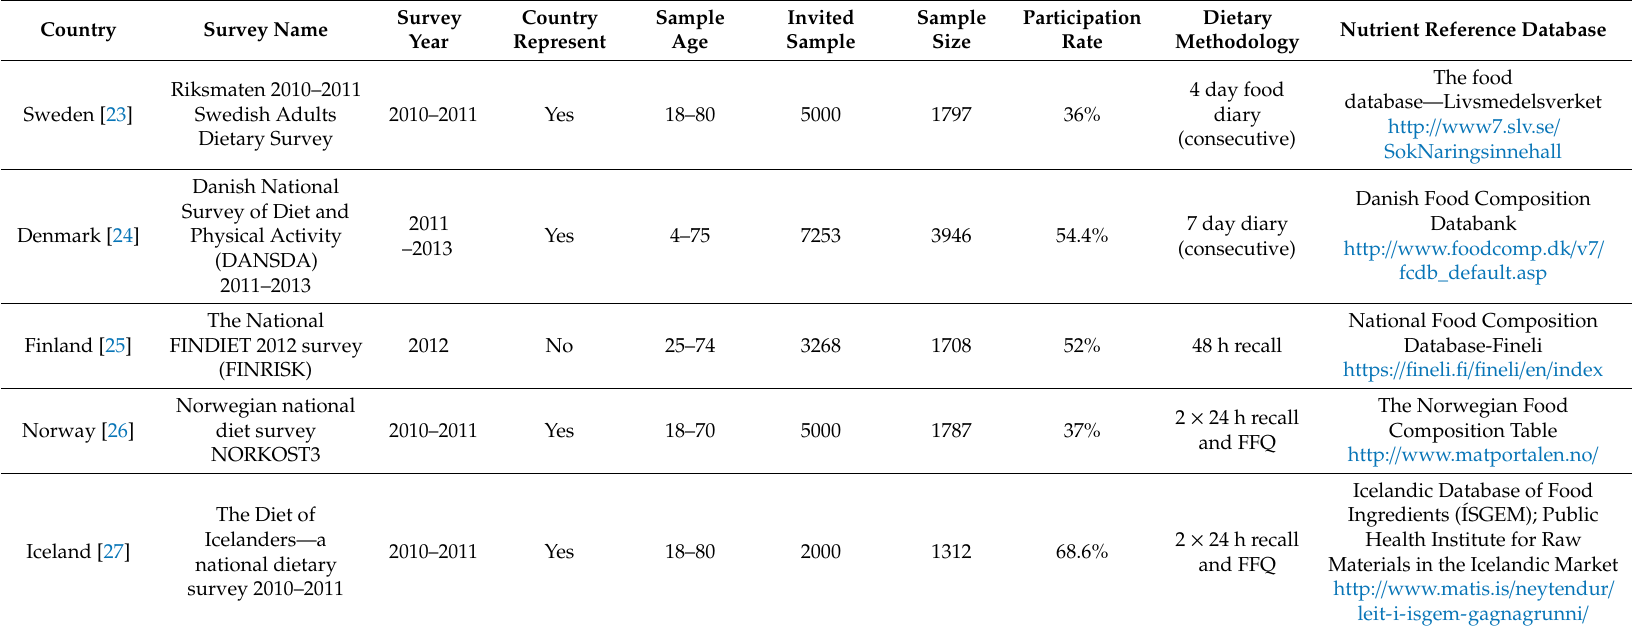
Abbreviations: FFQ, Food Frequency Questionnaire; h,